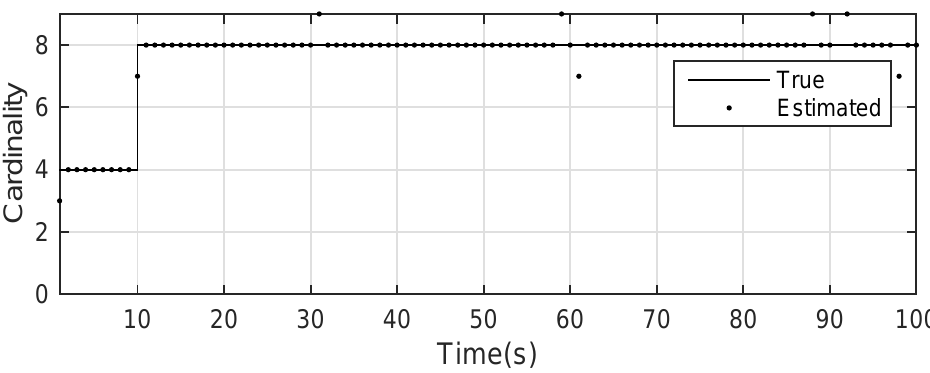
Figure 18. The estimated number of targets by Gibbs GLMB filter for experiment